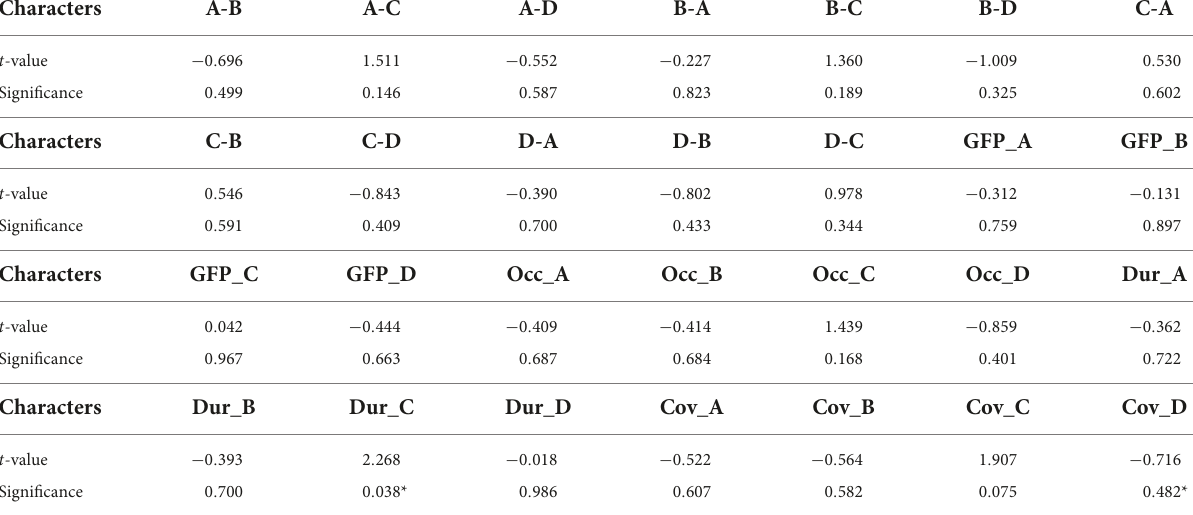
TABLE 2 Independent samples t -tests for 28 variables respectively with t -values and significance p